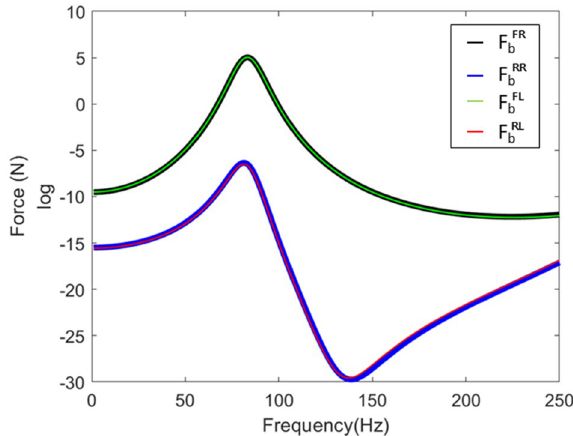
Figure 8. The blocked force generated at the connection part.